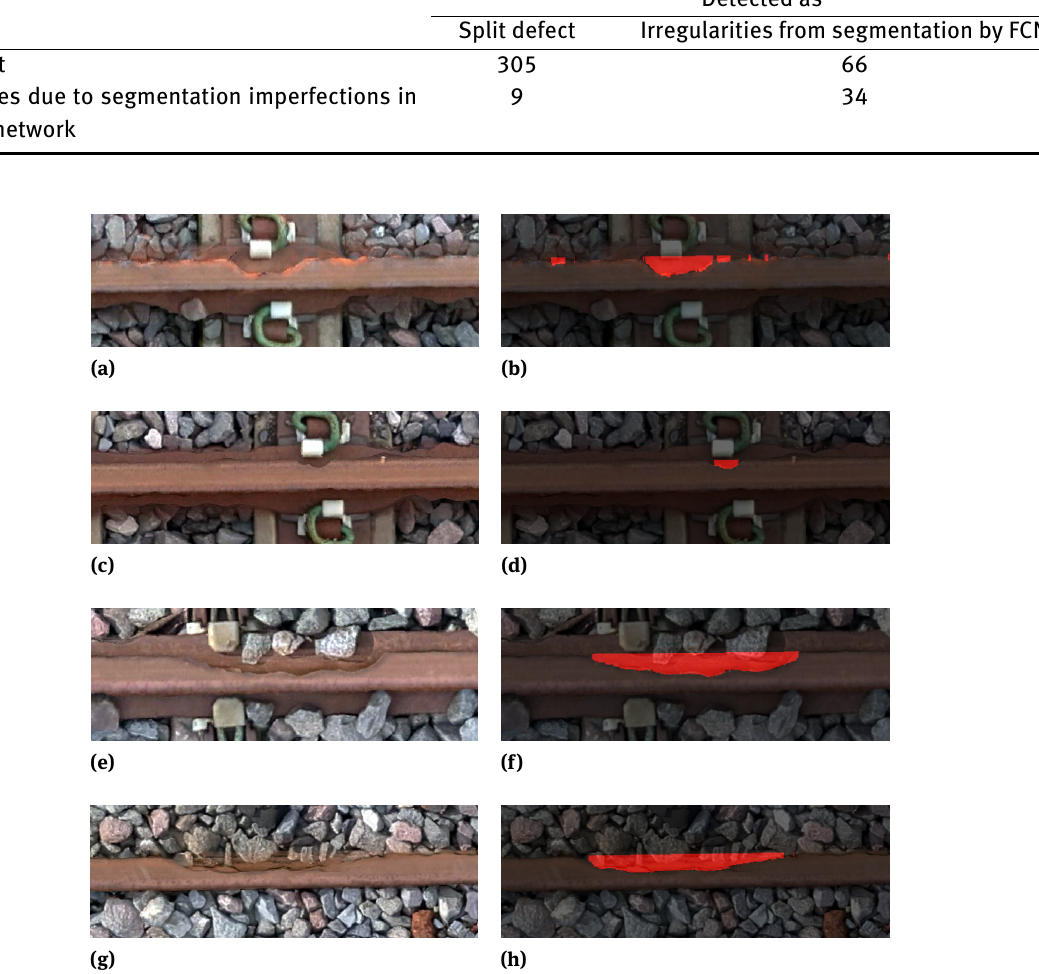
Figure 9: Algorithm effect for sample rail images in the track. a), c), e), g) show original track images, b), d), f), h) show corresponding split defects (marked in red) applied in track